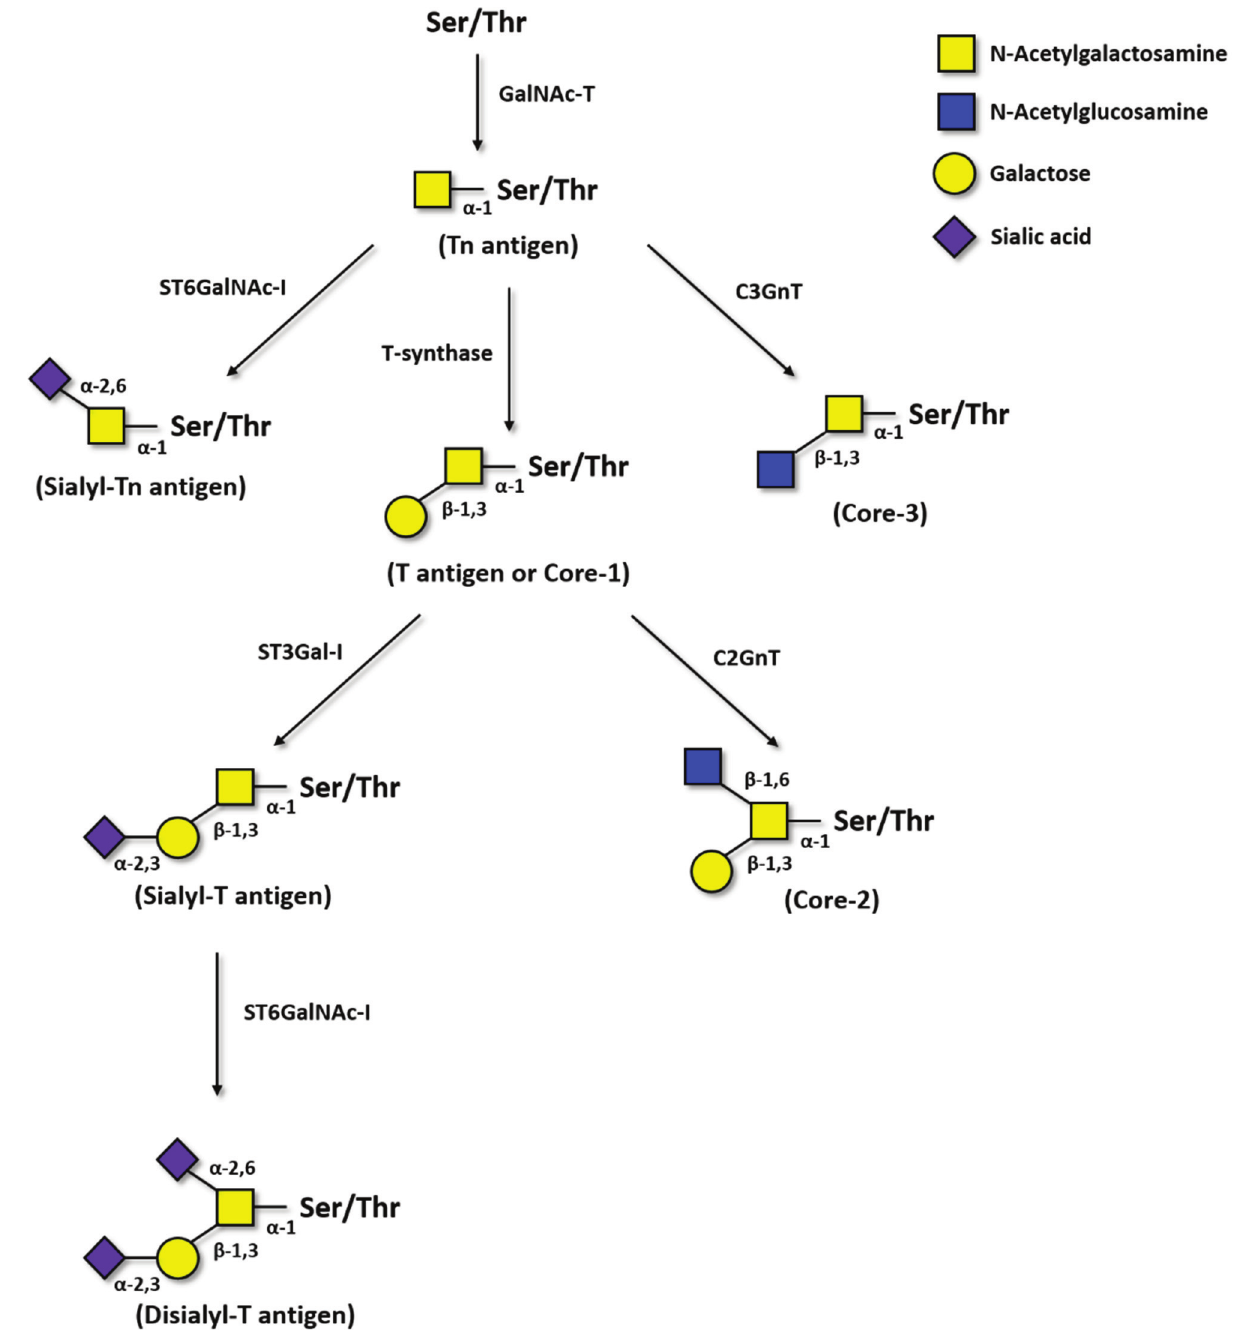
Figure 1. Pathways of Thomsen-Friedenreich antigens biosynthesis. First, GalNAc is transferred to a serine or threonine residue in a polypeptide by peptidyl- N -acetylgalactosaminyltransferases (GalNAc-T). GalNAc(cid:3)1-Ser/Thr, i.e. , the Tn antigen, is then converted by T-synthase to Gal(cid:4)1-3GalNAc(cid:3)1-Ser/Thr, i.e. , the T antigen or core-1 structure. The Tn antigen can be also sialylated by ST6GalNAc-I forming Neu5Ac(cid:3)2-6GalNAc(cid:3)1-Ser/Thr, i.e. , the sialyl-Tn. GalNAc(cid:3)1-Ser/Thr can also be converted to core-3 structures by the (cid:4)3GnT-6. T antigen is converted to core-2 structures by C2GnT-1, -2, and -3 or can be sialylated by ST3Gal-I, originating the sialyl-T antigen. Moreover, sialyl-T antigen can be sialylated by ST6GalNAc-I originating disialyl-T